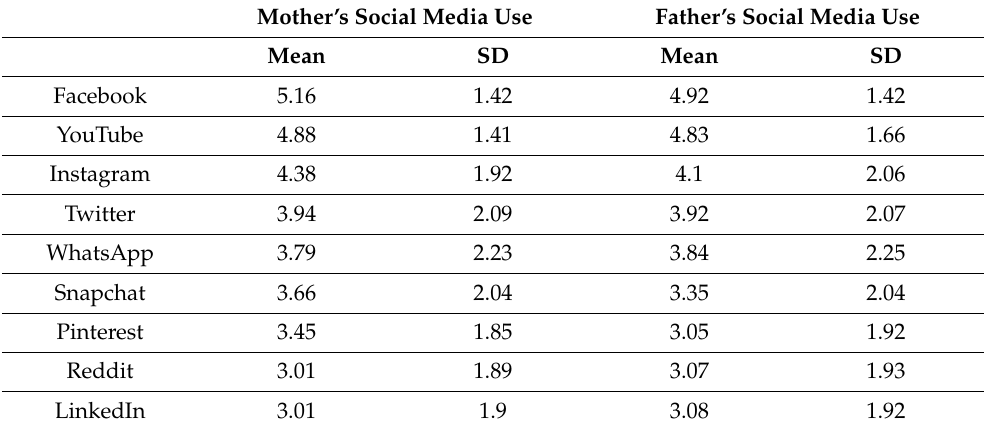
Table 2. Means and standard deviations for social media application use among parents.